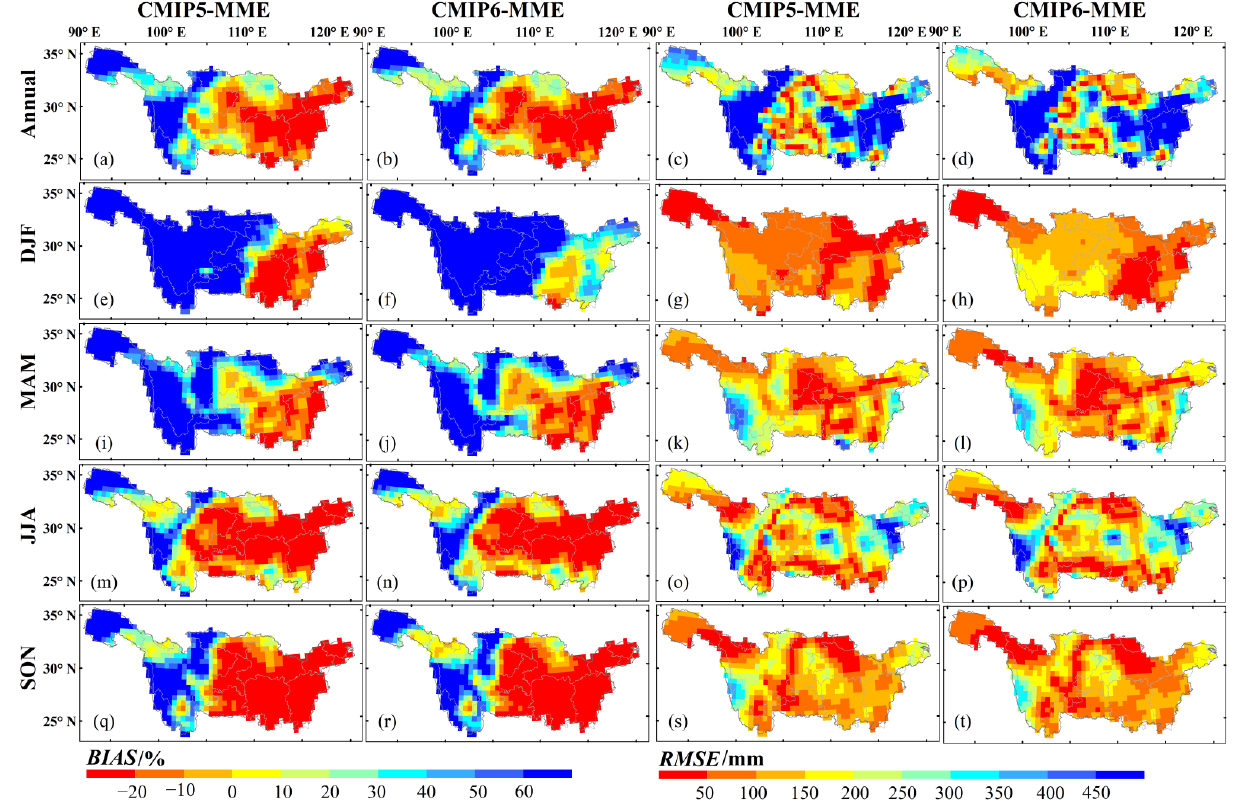
Figure 4. The spatial pattern of relative bias (left two columns) and root-mean square error (right two columns) (projection minus observation) in CMIP5-MME and CMIP6-MME of annual ( a – d ), DJF ( e – h ), MAM ( i – l ), JJA ( m – p ), and SON ( q – t ) precipitation for the period 2015–2020. The first and third columns of each row belong to CMIP5-MME and the second and fourth columns belong to CMIP6-MME.